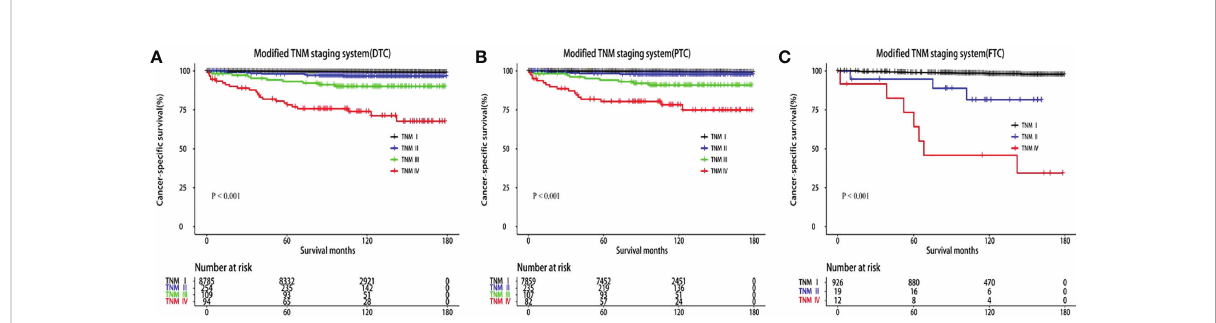
FIGURE 2 Kaplan – Meier survival curves of cancer-speci fi c survival according to the modi fi ed TNM staging system. (A) Differentiated thyroid carcinoma (DTC). (B) Papillary thyroid carcinoma (PTC). (C) Follicular thyroid carcinoma